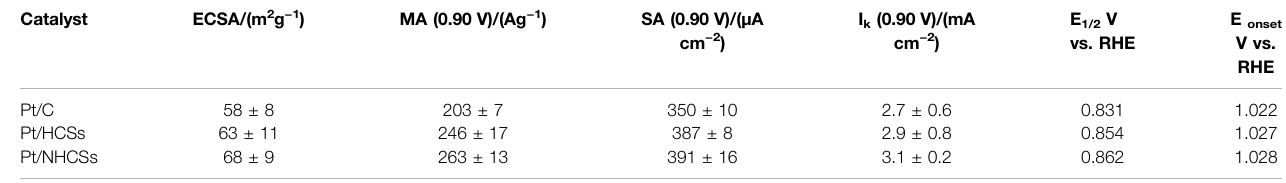
TABLE 1 | Calculated ECSA and ORR activity for the Pt/HCSs, Pt/NHCSs and the commercial benchmark Pt/C catalysts. MA, SA, I k measurements obtained at 0.90 V vs. RHE. Catalyst